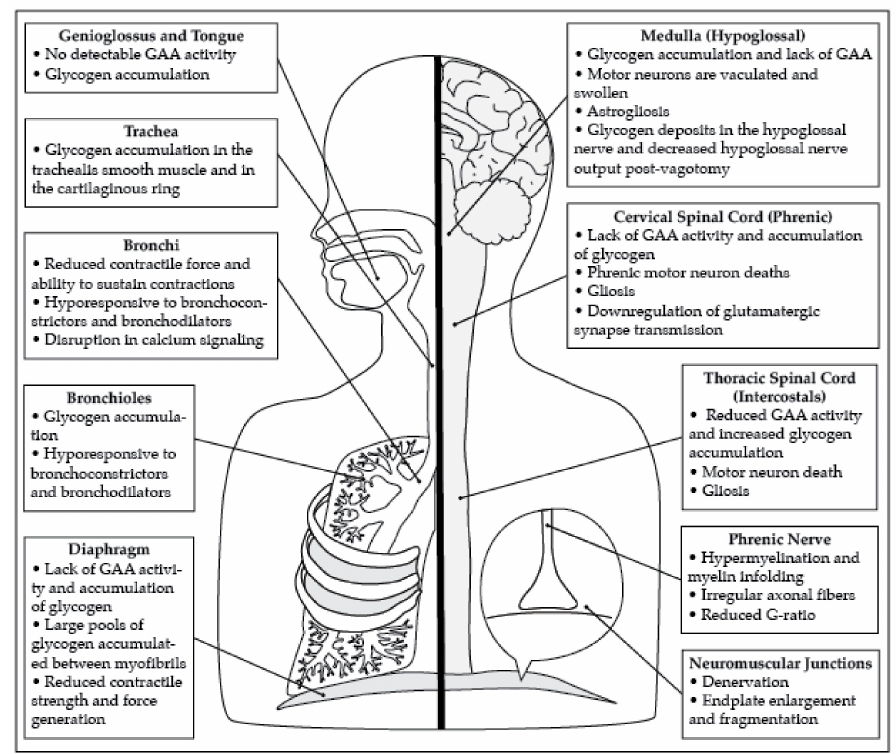
Figure 1. Pompe disease results in extensive pathology in both the muscular and neural components